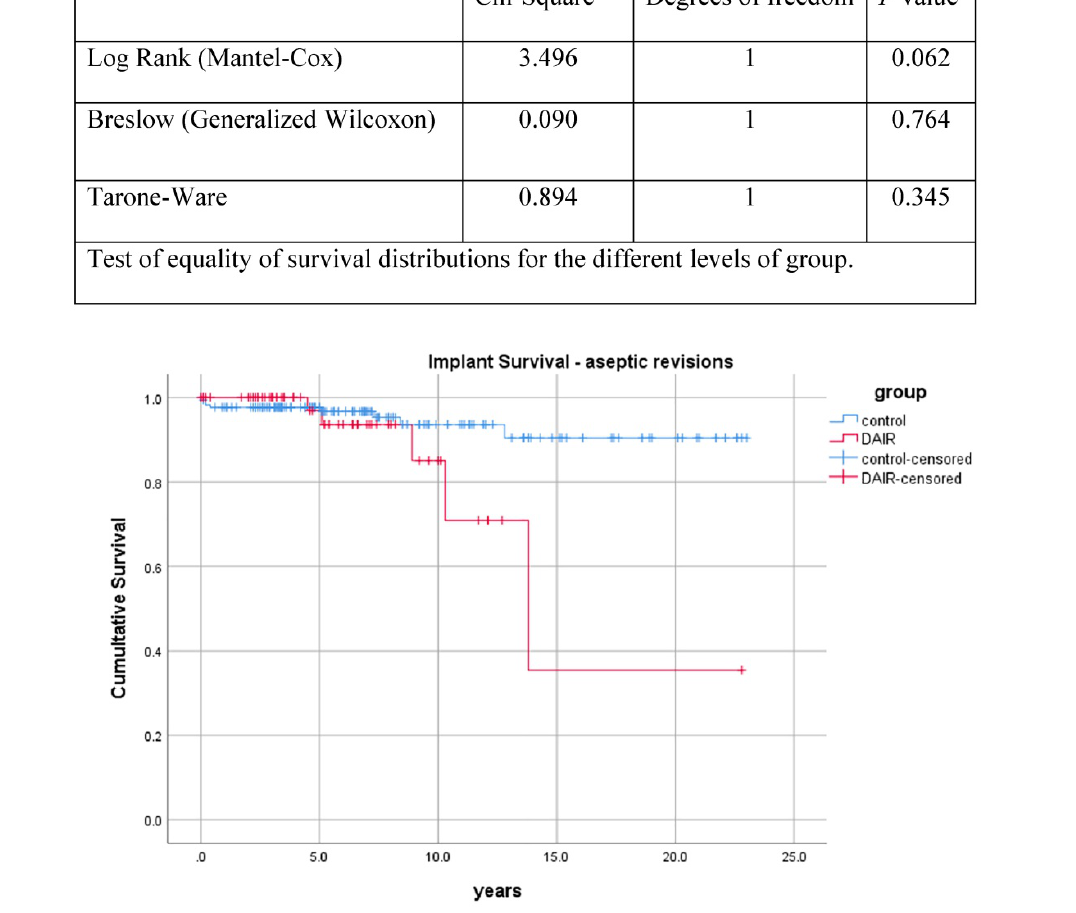
Figure 2. Kaplan-Meier curve of implant survival (revision for aseptic loosening of any component). Y-axis, cumulative proportion; X-axis, follow-up in